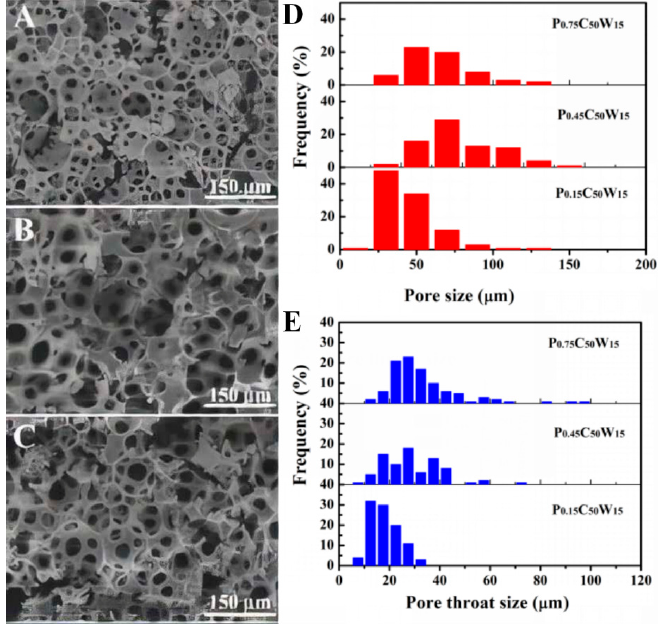
Figure 3. The SEM images ( A ), ( B ), and ( C )of P x C 50 W 15 templated from C/W HIPEs containing 0.15, 0.45, and 0.75 g Ca-BDC, respectively; ( D ) and ( E ) are the distribution charts of pores and pore throats, respectively, which were measured and counted from corresponding SEM